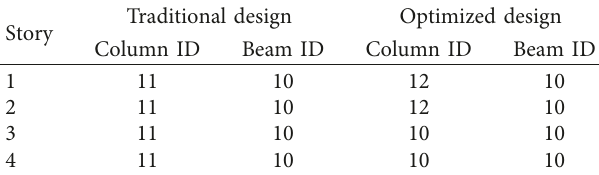
Table 2: Sections for columns. Table 3: Design results for the 4-story